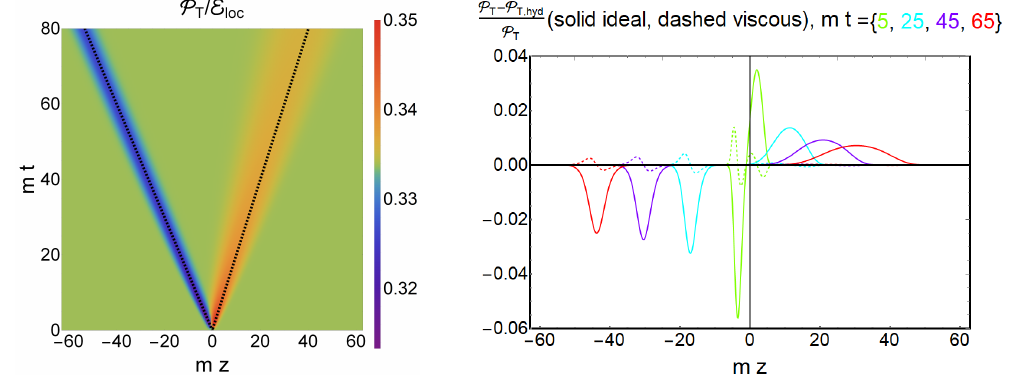
Figure 11: (left) For the evolution of Fig. 6 we show the ratio of the transverse pres- sure over the energy density in the local restframe together with the shock velocities (black, dashed) computed from Eqn. (11). Most of the evolution is close to ther- = E / 3, in green in the colour coding), but around the shocks mal equilibrium ( P T loc there are significant deviations. (right) For several times we present the deviations with respect to ideal hydro (solid) and first order viscous hydrodynamics (dashed), normalised to the transverse pressure itself. The entire evolution can be described by viscous hydrodynamics with better than 1% accuracy.